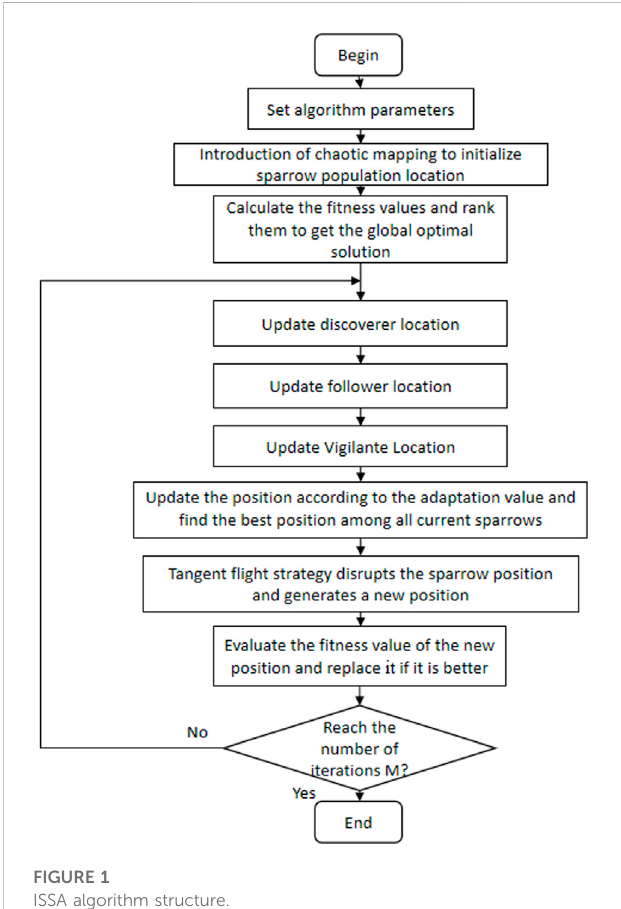
FIGURE 1 ISSA algorithm